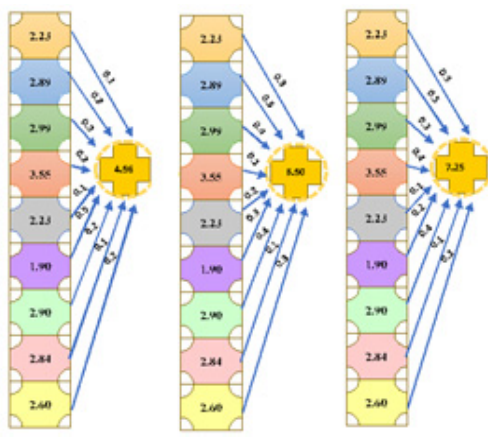
Figure 10. Output of calculation.